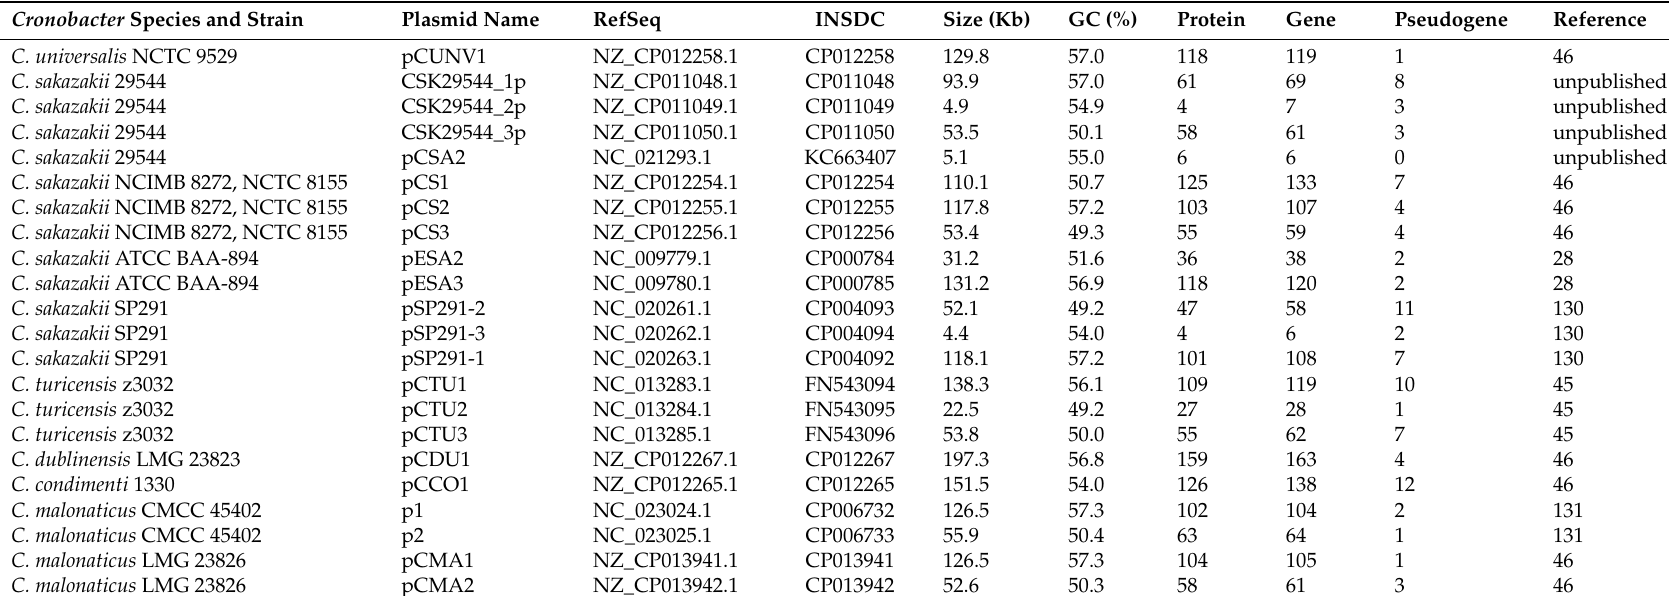
Table 4. Characteristics of known plasmids possessed by Cronobacter species a,b